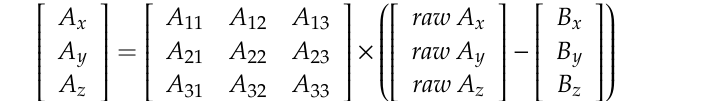
Figure 4. Graph showing monitoring data registered by the single ‐ module prototype and the commercial sensor. The red, blue, and black lines represent the data registered by the single ‐ module prototype, while the green line represents the inclination measured by the commercial sensor. 3. Multi ‐ Module Inclinometer 3.1. System Structure The in ‐ place inclinometer is composed of three parts: a chain of modules, each containing a measuring unit composed of a MEMS IMU sensor array and a low ‐ cost Arduino ® Board; a master board responsible for acquiring, elaborating, and storing data measured by each single measuring unit; and a power system. Especially, since landslides are often located in remote places, the power system is composed of (i) a 50 W solar panel; (ii) a 12 A lead battery for storage energy; (iii) a charge controller; and (iv) a DC–DC voltage converter to adapt the 12 V of the battery into 5 V like Arduino ® alimentation. With this kind of configuration of the power system, the in ‐ place inclinometer is suitable also for long ‐ term observation. As developed, the overall cost of a single module is around €100, the cost of the master station is approximately €120, and the cost of the power supply is around €80. On this basis, an inclinometer composed of five modules, able to work in a landslide that is 5–10 m deep, has a cost of approximately €700. It is important to notice that the reduced cost of the developed system is only related to the system itself. Indeed, the installation costs are essentially equal to those of a commercial system.